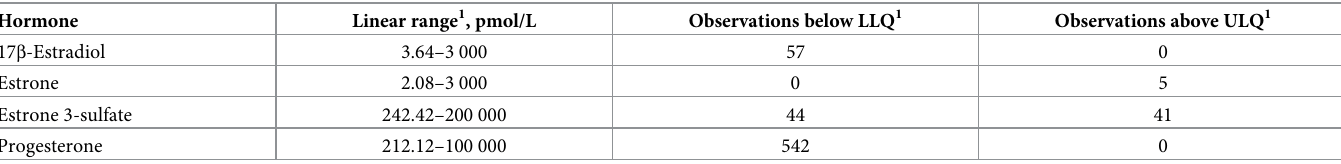
Table 1. Linear range and quantification limits of the hormone measurements.